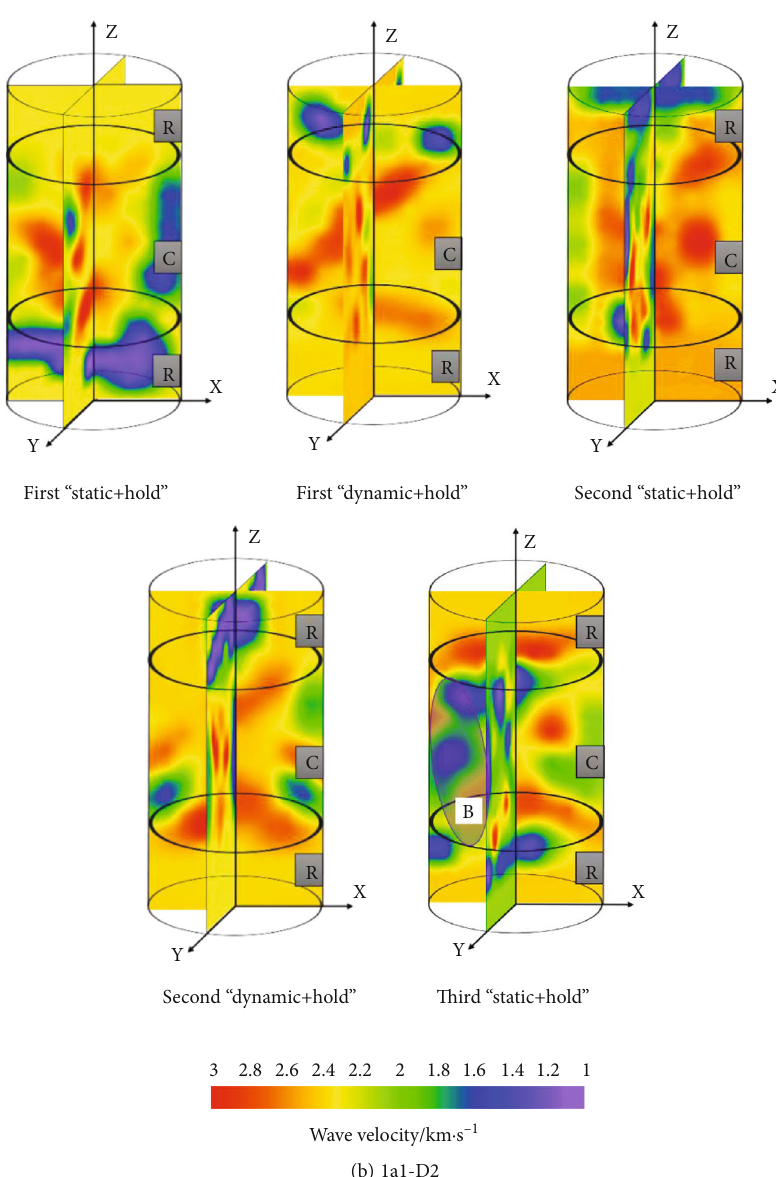
Figure 14: Acoustic wave velocity distribution.